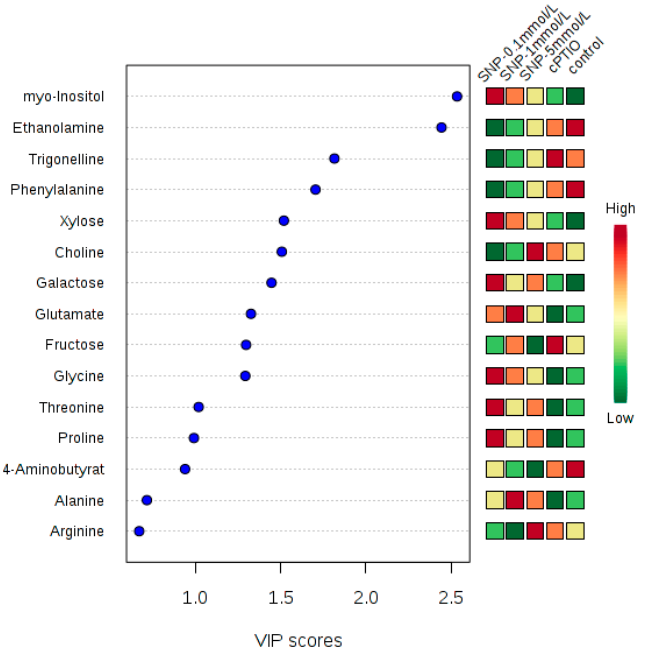
Figure 4. Identified 10 metabolites which had VIP value greater than 1 after NO treatment.